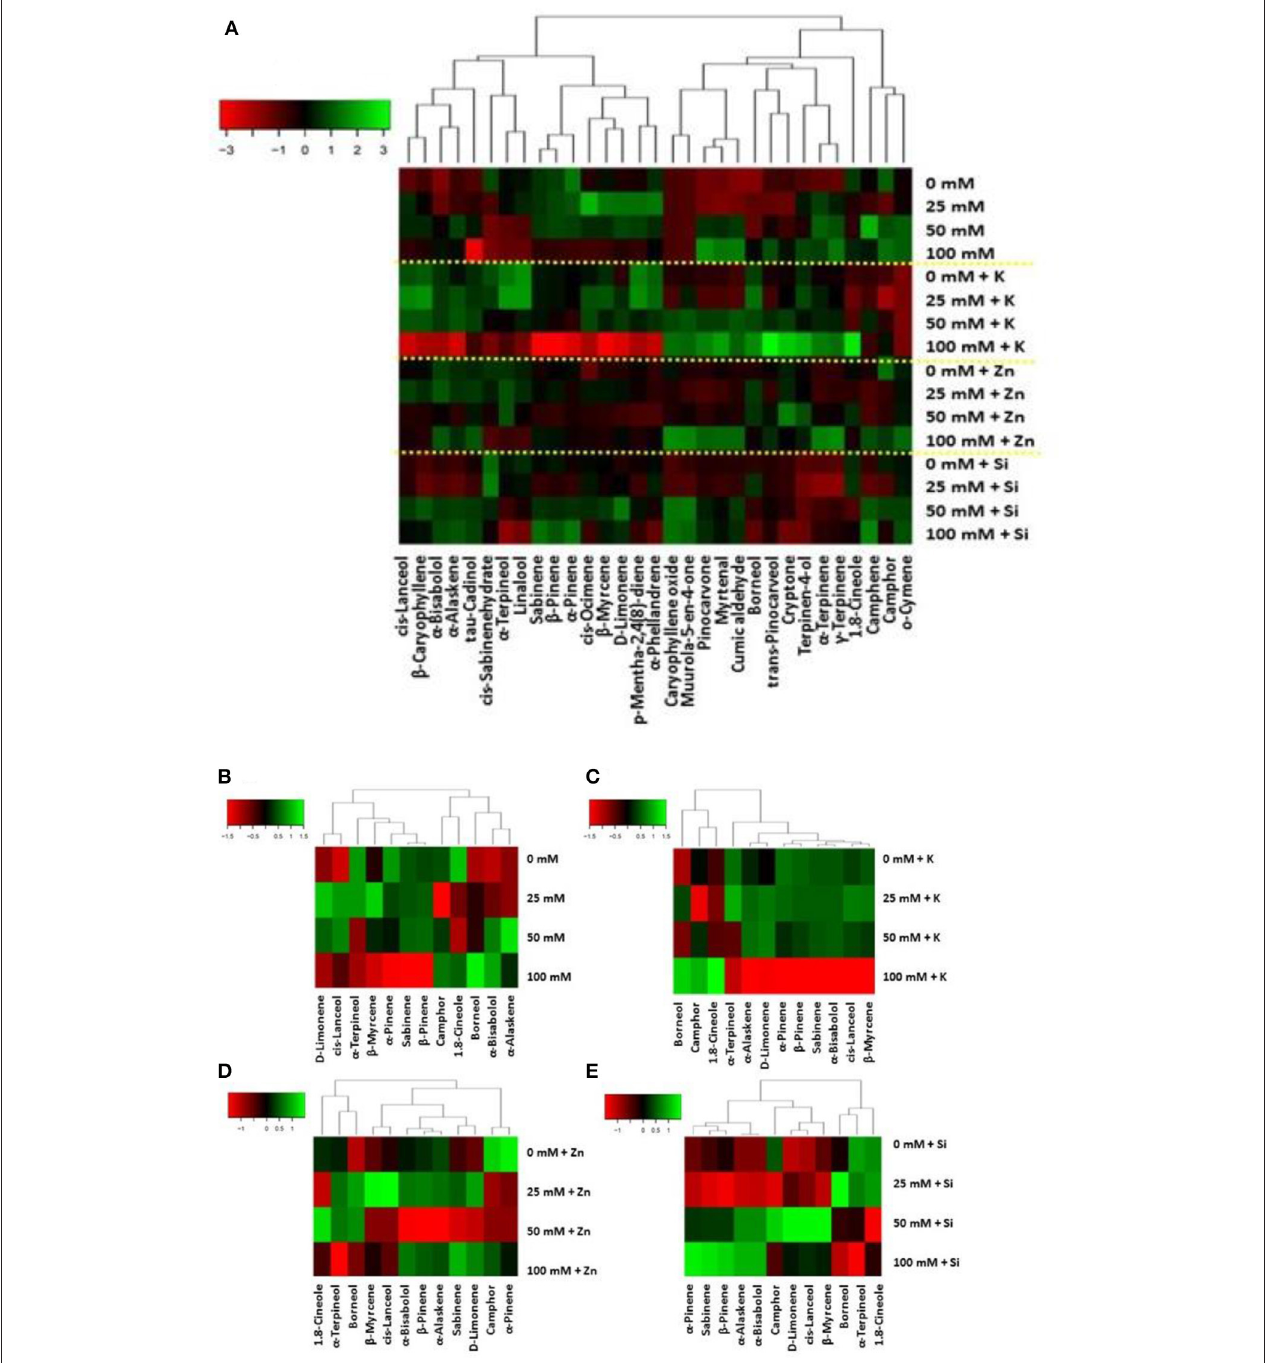
FIGURE 7 | Metabolite changes in leaves of lavender. Heat map representing relative expression of volatiles in total (A) elicited in leaf tissue following (B) salinity (25–50–100mM NaCl) and foliar (C-E) applications (no foliar, K, Zn, and Si) as compared to control (no saline) plants.